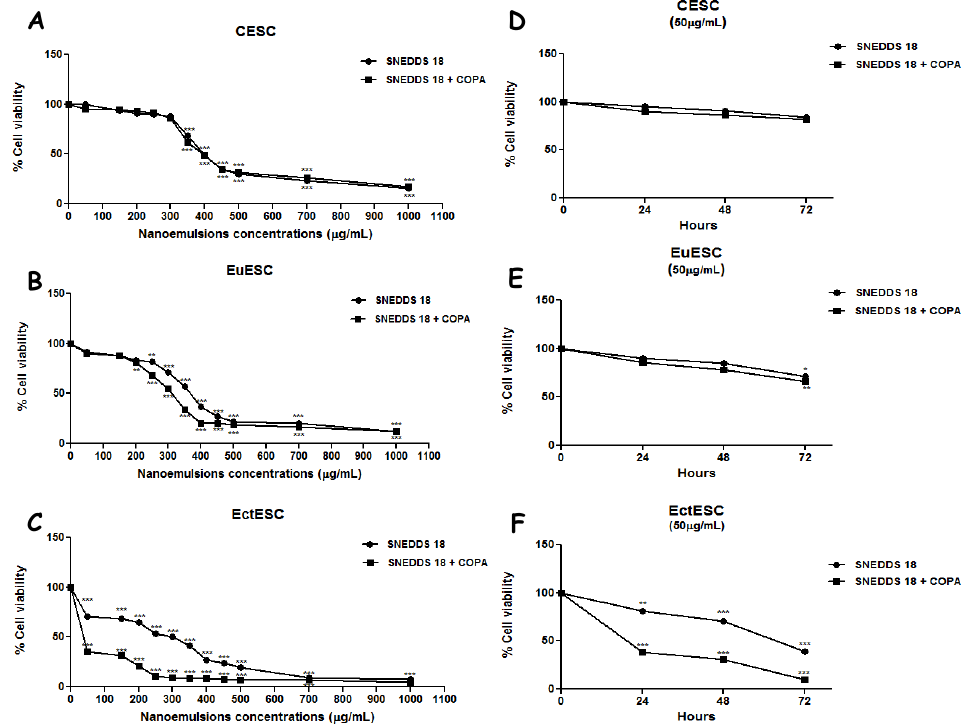
Figure 1. Endometrial stromal cell viability after incubation with nanoemulsions. In ( A – C ), CESC, EuESC, and EctESC were treated with different concentrations of SNEDDS-18 or SNEDDS-18/COPA for 48 h in complete medium. In ( D – F ) CESC, EuESC, and EctESC were treated with 50 µ g/mL of SNEDDS-18 or SNEDDS-18/COPA for 24, 48, or 72 h. Cell viability was analyzed by the MTT method. Data are expressed as mean ± standard deviation of cell viability (in %). * p < 0.05; ** p < 0.01; *** p < 0.001 when comparing nanoformulation-treated groups with nontreated group. CESC: Endometrial stromal cells obtained from topic endometrium of patients without endometriosis; EuESC: Endometrial stromal cells obtained from topic endometrium of endometriosis patients; EctESC: Endometrial stromal cells obtained from ectopic endometrium of endometriosis patients (endometriotic lesions); SNEDDS-18: Nanoemulsion containing Babassu oil; SNEDDS-18/COPA: nanoemulsion containing Babassu oil and Copaiba oil